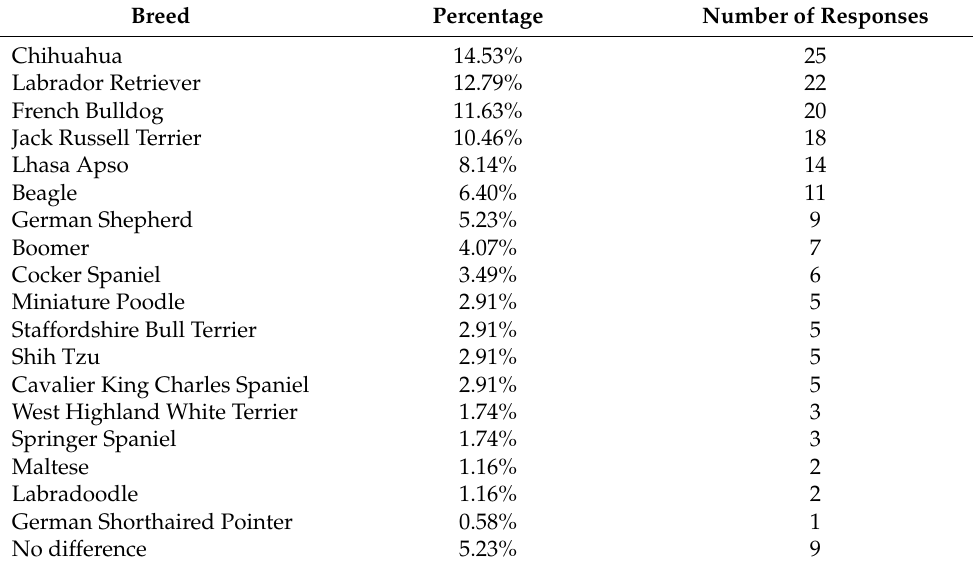
Table 3. Reported predisposition of anal sac disease per dog